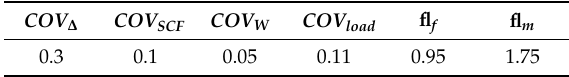
Table 14. Statistical parameters for reliability assessment of samples.